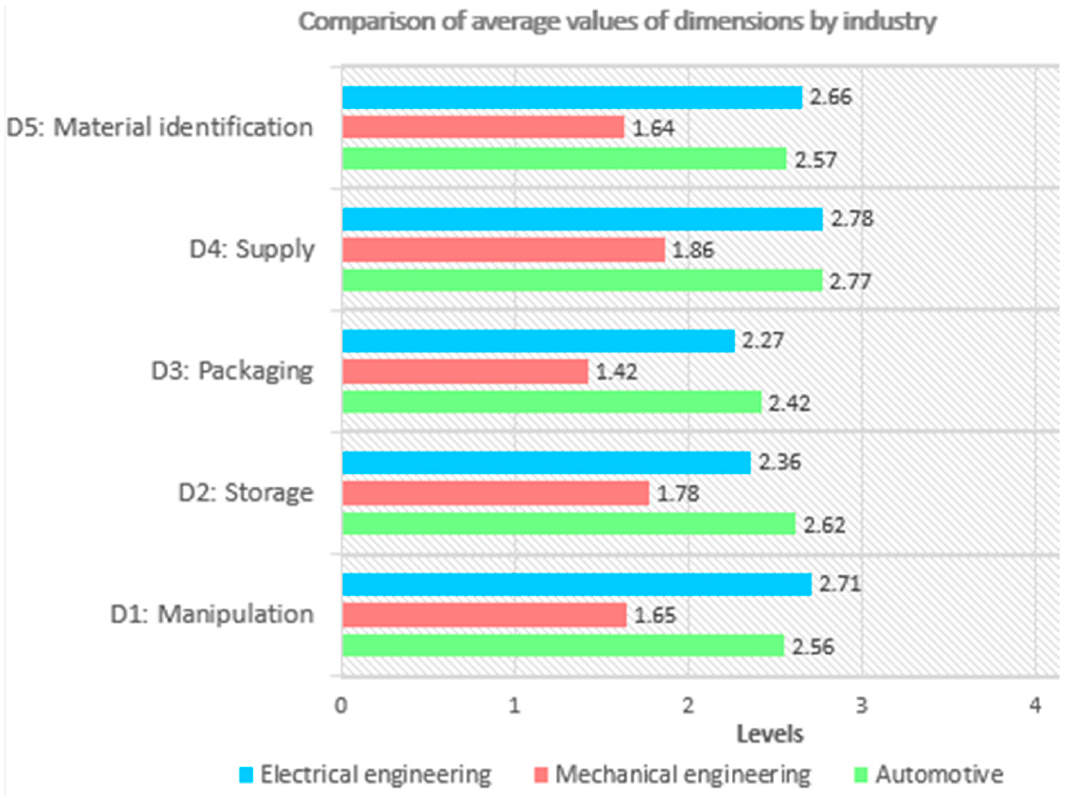
Figure 17. Comparison of average values of dimensions in the automotive and mechanical engi- neering industries.